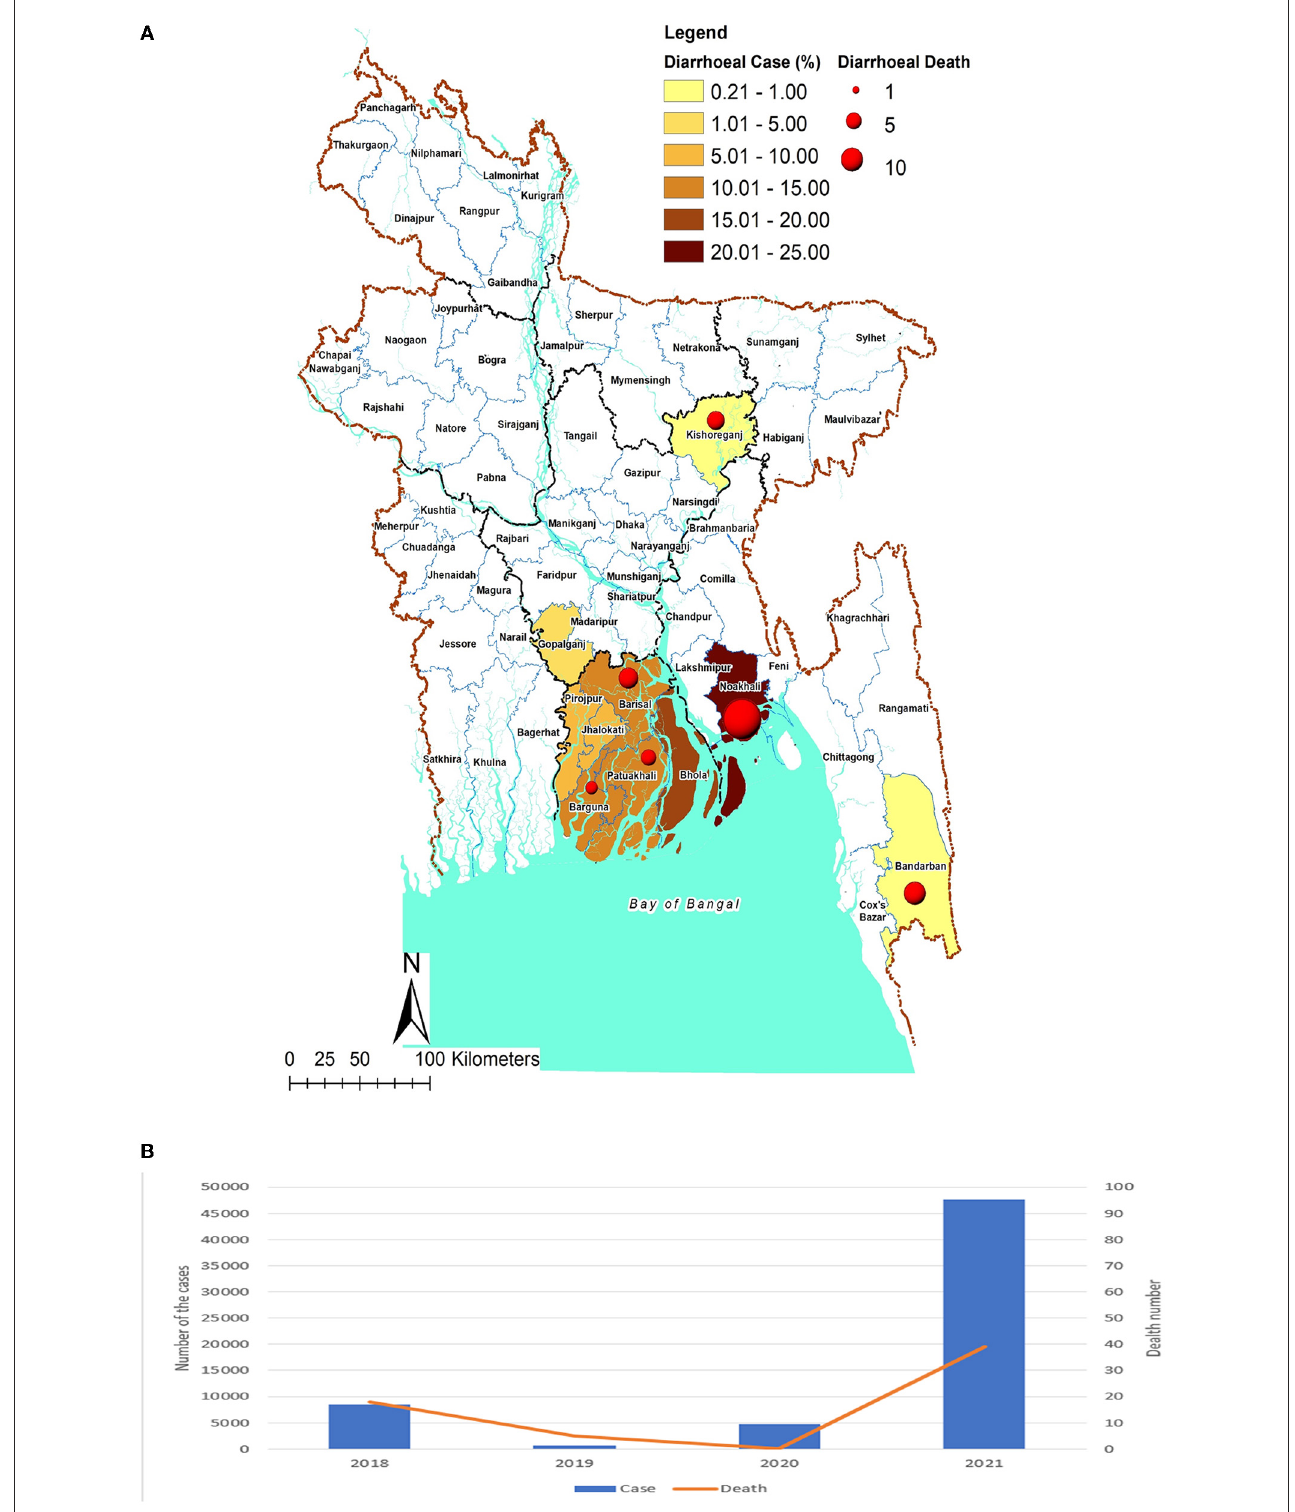
FIGURE1 (A) The number of cases and death due to diarrhoeal discase outbreaks in different districts/upazila in Bangladesh, 2021. Map source: Banglapedia Bangladesh map digitize and data updated by icddr,b. (B) The number of cases and deaths dur to diarrhoeal disease outbreaks in different districts/upazlia in Bangladesh, 2018–2021; Data source from the print and electronic